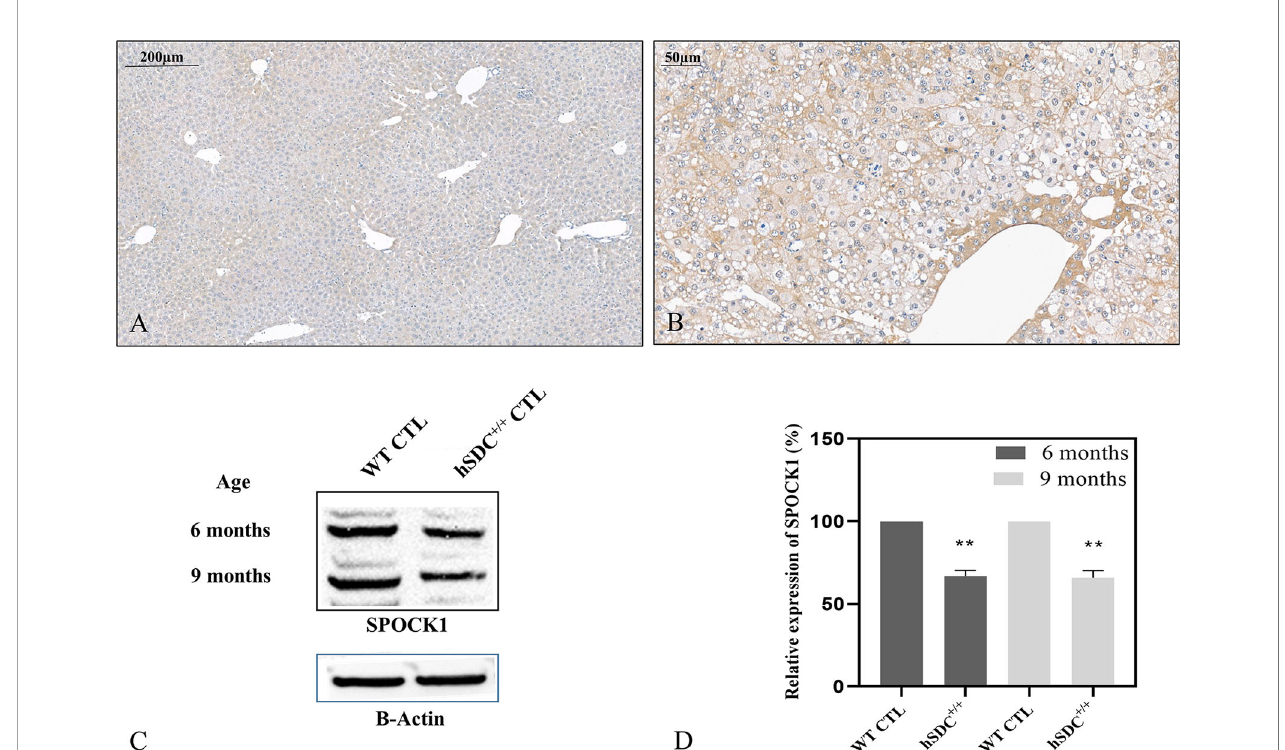
FIGURE 12 | SPOCK1 expression in hSDC-1 +/+ transgenic control liver and its diethylnitrosamine (DEN)-induced cancer. (A) Weak SPOCK1 positivity was detected around the central veins in hSDC-1 +/+ control liver. (B) Hepatocellular cancer 11 months after DEN exposure in the hSDC-1 +/+ liver. The intensity of SPOCK1 staining is still modest, except around the central veins. Western blotting (C, D) supports the results of immunohistochemistry; SPOCK1 expression in hSDC-1 +/+ control livers is lower than that in wild-type liver throughout the whole experiments. **p <